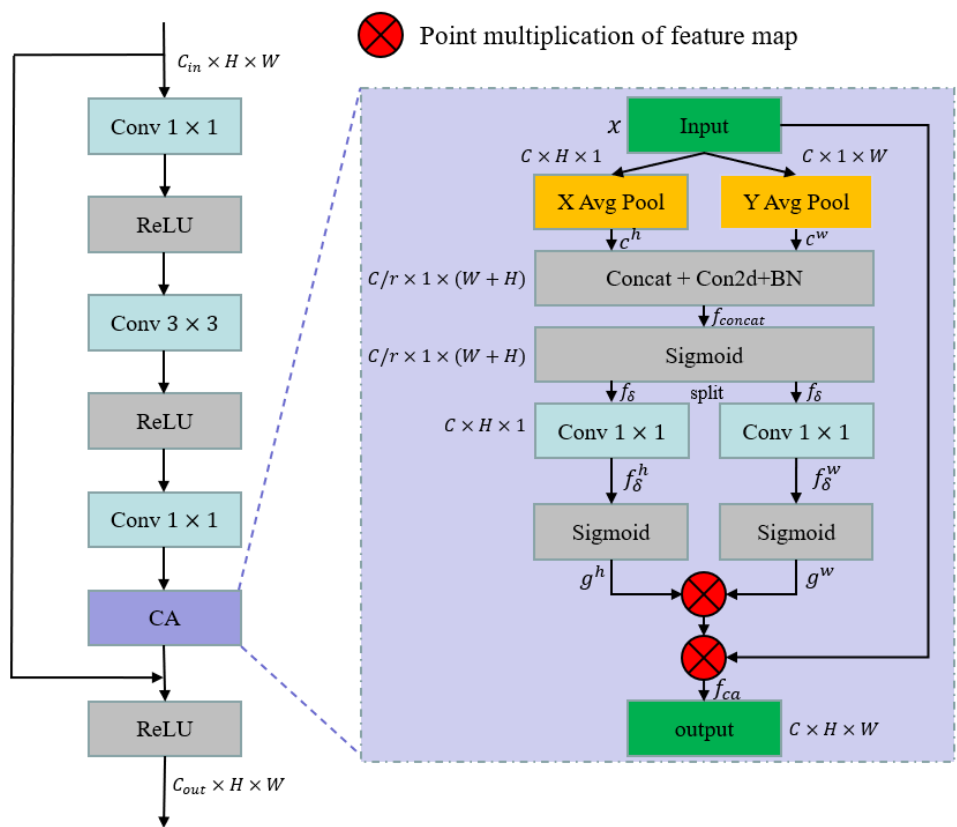
Figure 3. The architecture of CA-ResNet in one block. ‘X Avg Pool’ and ‘Y Avg Pool’ represent the 1D horizontal global-pooling and 1D vertical global-pooling, respectively. r is the reduction ratio of channels.